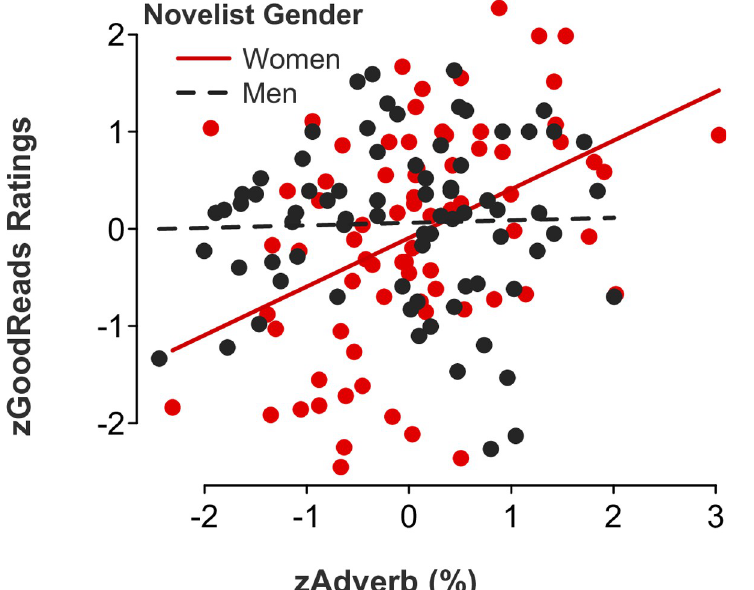
Fig 7. Novel ratings as a function of adverb use and novelist gender.